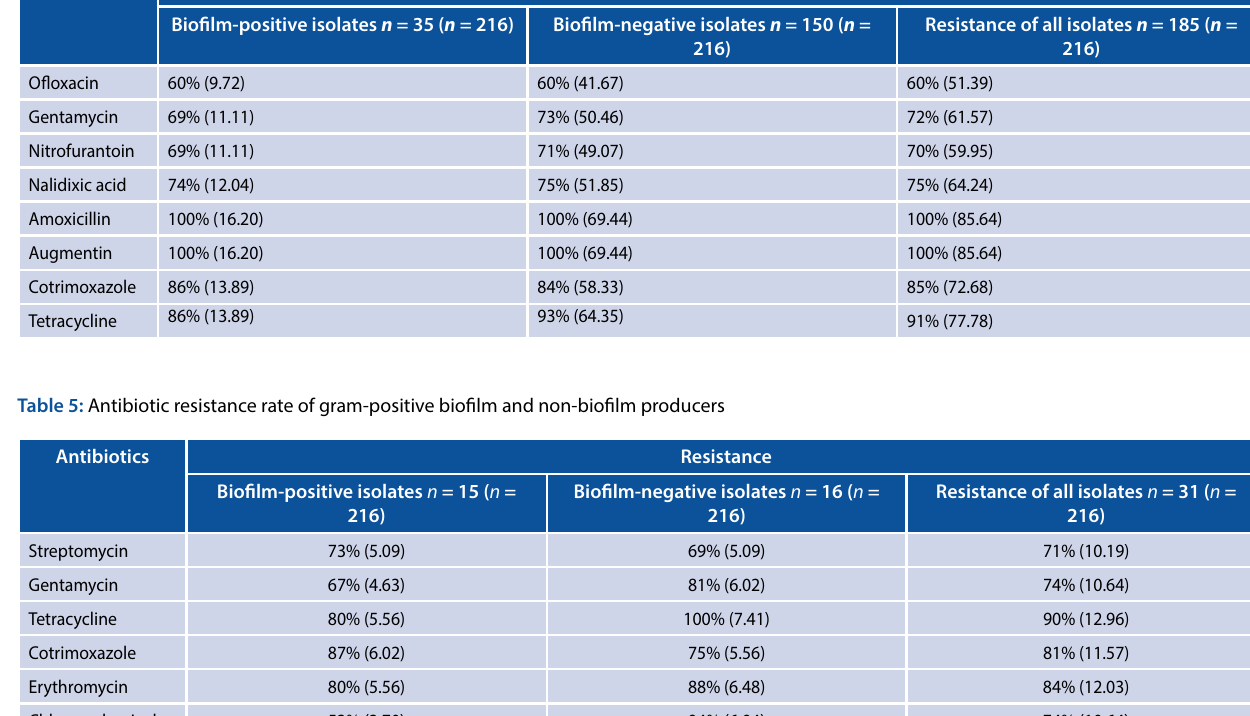
Table 4: Antibiotic resistance rate of gram-negative biofilm and non-biofilm producers Antibiotics Resistance